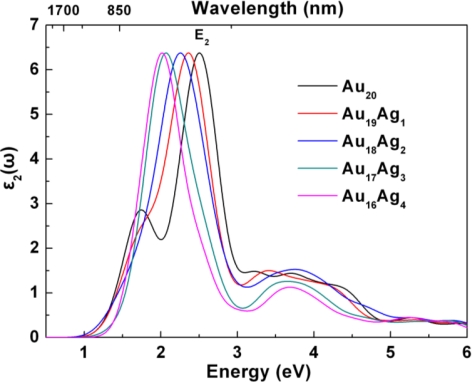
The tunable imaginary part of dielectric function ɛ2(ω) of Au20−nAgn clusters.